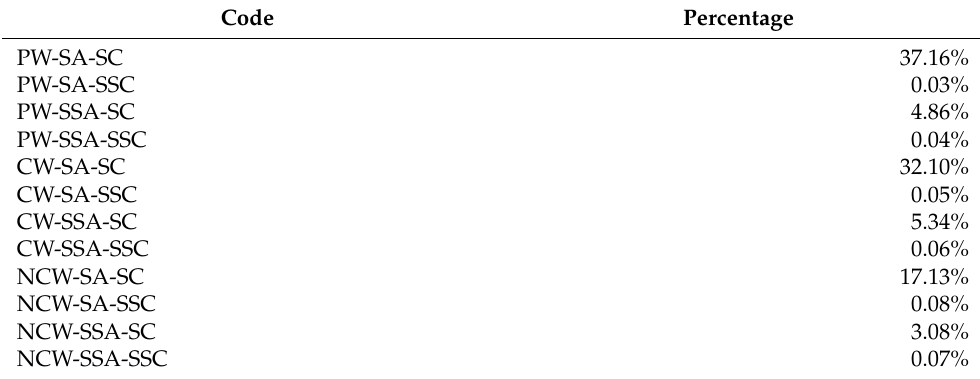
Table 9. Percentages of measurements in a year.